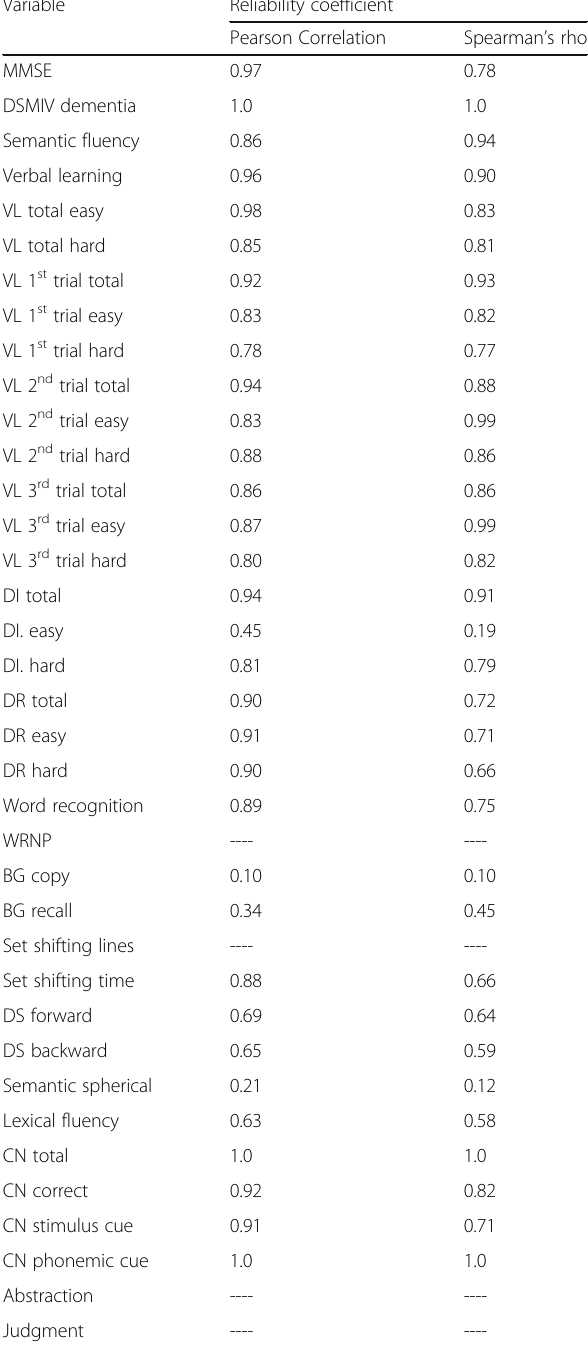
Table 1 Test-retest reliability ( N =